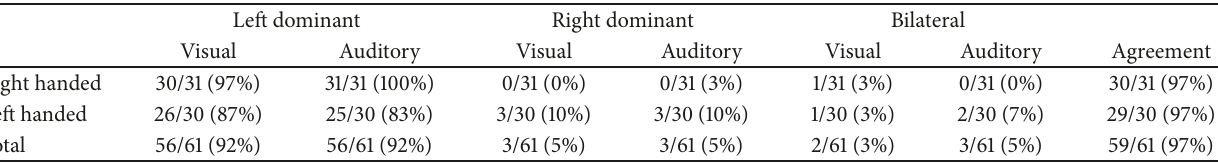
Table 2: Agreement between paradigms for classification of individuals as left, right, or bilaterally language dominant. Left dominant Right